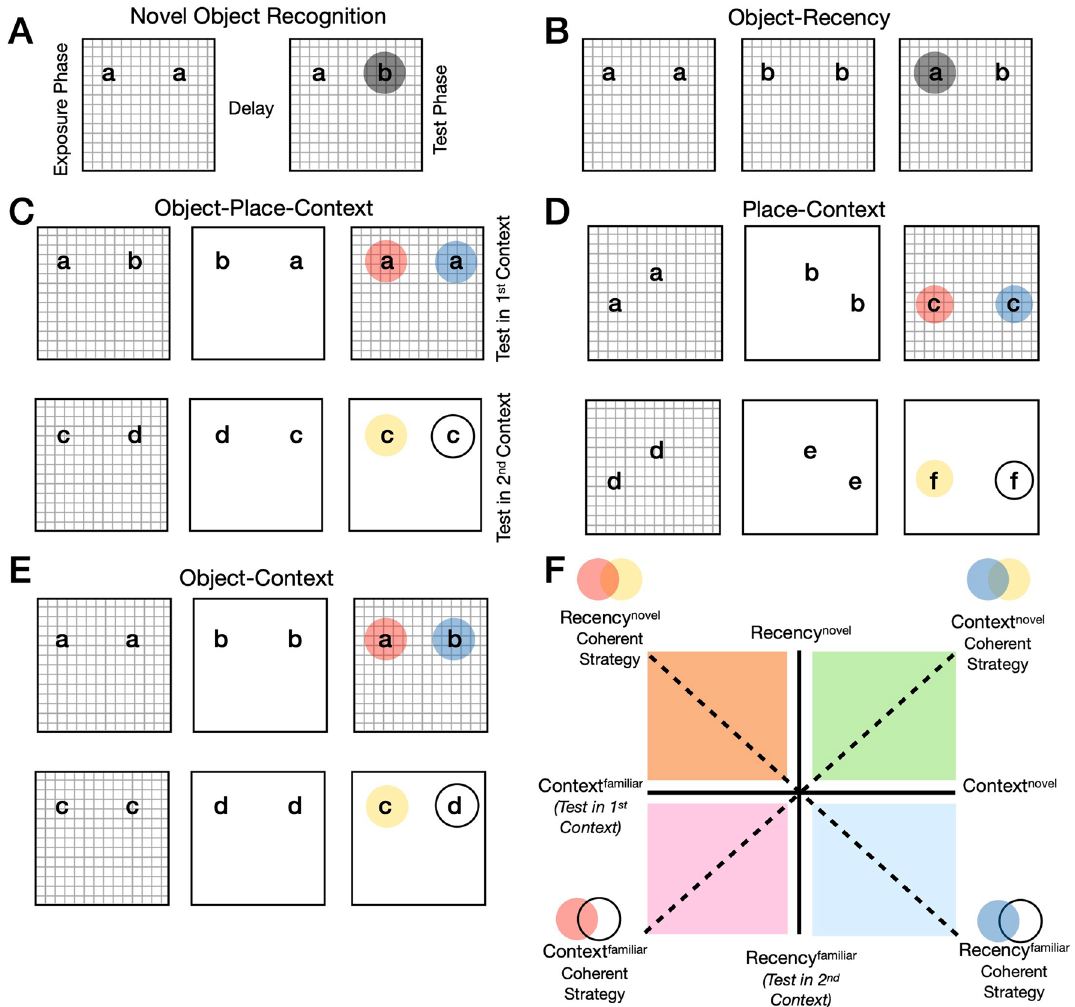
Figure 1. Schematics of various object recognition tasks with 2 objects. ( A ) Standard novel object recognition in the same environment with 1 exposure phase (left), a delay and a novel object present at the test phase (right). The highlighted grey circle denotes expected novelty-based discrimination. Lower case letters denote objects. ( B ) Object-recency task in the same environment with 2 exposure phases (left and middle) and the test phase (right). The highlighted grey circle denotes expected novelty-based discrimination on the object least recently seen. ( C ) Object-place-context task in two different environments (i.e., contexts) with 2 exposure phases (left and middle). Test phase can be made in the 1st context (upper right) or test can be made in the 2nd context (lower right). In test in the 1st context trials, the highlighted blue circle can denote novelty discrimination of integrated object-place-context association or the highlighted red circle can denote novelty discrimination of object in place recency (note that discrimination is ignorant to context, see B ). In test in the 2nd context trials, the highlighted yellow circle can denote novelty discrimination of integrated object-place-context or novelty discrimination of object-place recency (they are overlapping). ( D , E ) Other 2 objects/exposure/ contexts tasks which are susceptible to a context-based versus recency-based strategy where F is applicable. ( F ) Strategy scatterplot for 2 object/context/exposure object recognition tasks. Based on ( C – E ) one can average discrimination ratio scores separately for both for test in the 1st context trials and test in the 2nd context trials and plot them for each animal. The average context D2 for trials when test was made in the 1st context on the x-axis, and for trials when test was made in the 2nd context on the y-axis. Thus, one can form angular data and use directional statistics, which can enhance interpretive power if animals are behaving differently to chance. Context novel /Recency novel denote exploration on the basis of object related novelty preference. Context familiar / Recency familiar denote exploration on the basis of object related familiarity